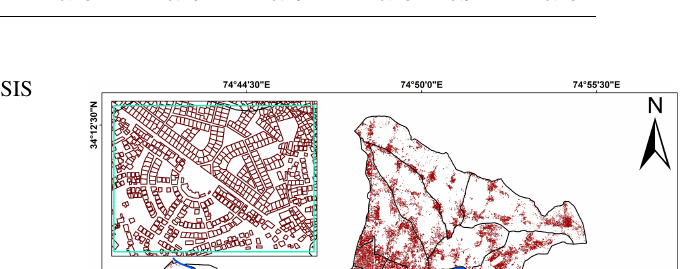
Table 4. Pairwise matrix showing weights for each of the factors used in the AHP model. Average Masonry Pounding Irregular Average floor building possibility building road Building Parameters height (%) (%) (%) width density Sum Weight Average floor height (m) 0.12